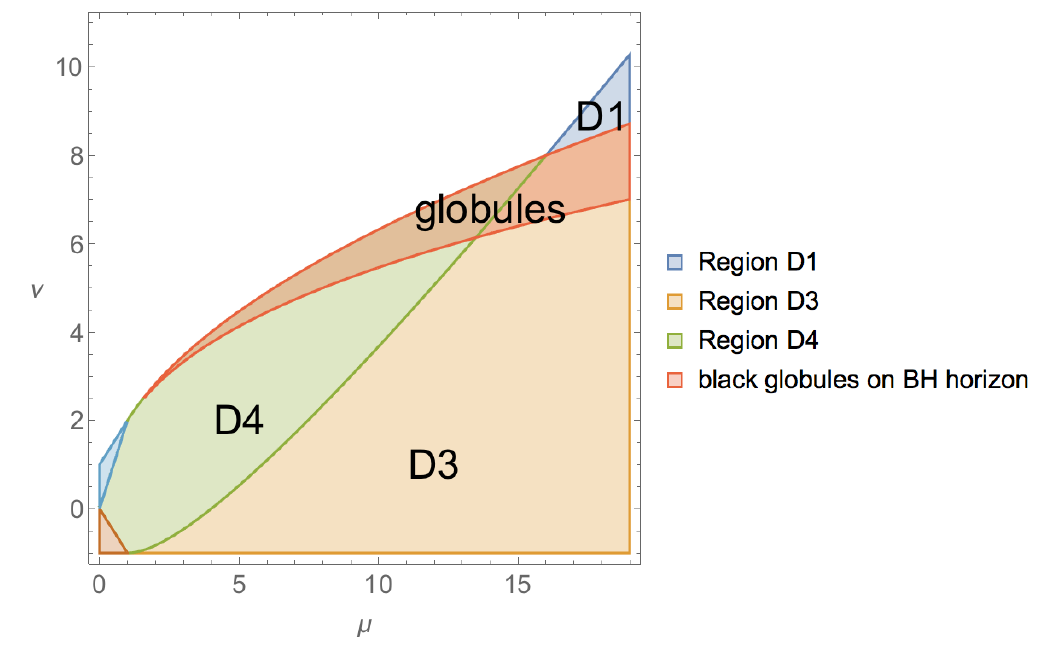
Figure 4 . Plot of the ( (cid:22); (cid:23) ) parameter space with the region of black globules denoted in red. Note that it includes part of regions D3 and